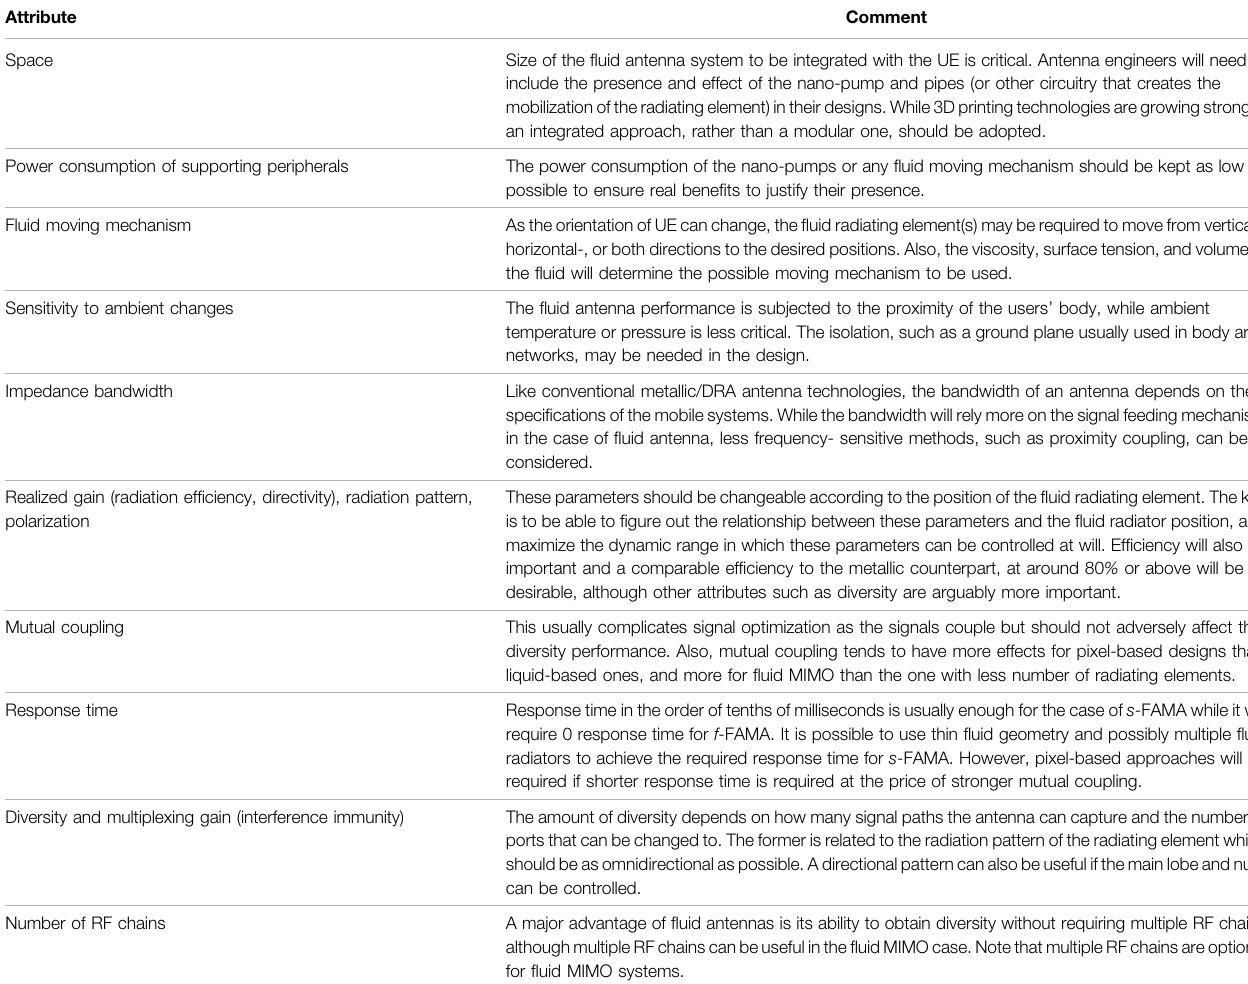
TABLE 2 | Guidelines for designing fl uid antennas at